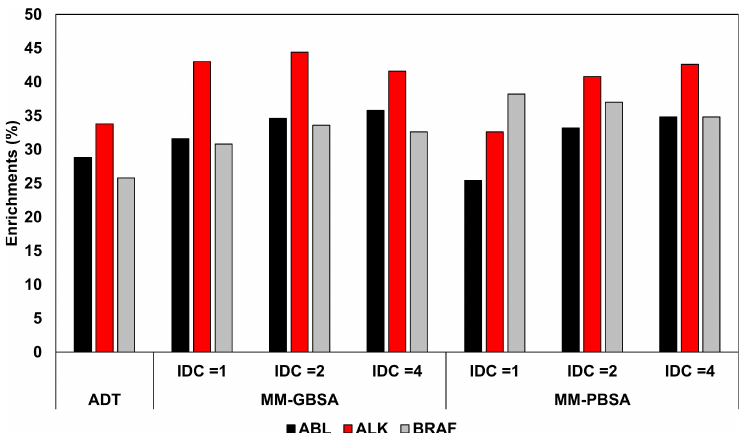
Figure 1. Enrichments (%) obtained for the top-scored 500 compounds of ABL, ALK, and BRAF databases, using Autodock (ADT) and the different Molecular Mechanics-Generalized Born Surface Area (MM-GBSA) and Molecular Mechanics-Poisson Boltzman Surface Area (MM-PBSA) methods tested by Hou and co-workers.